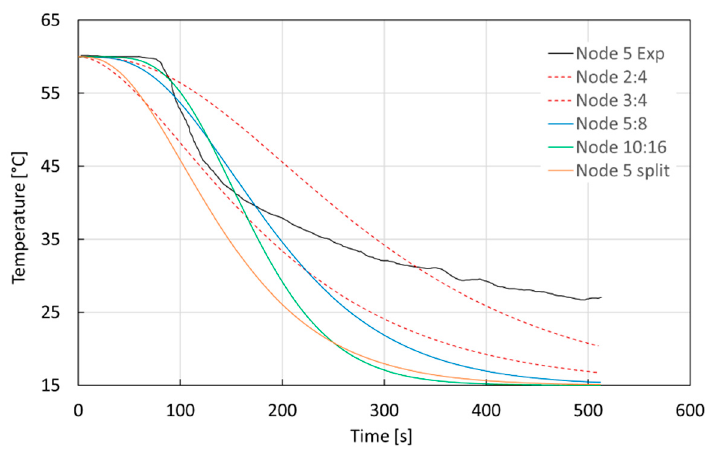
Figure 22. Experimental temperature evolution at node #5 vs. simulation results—15 dm 3 /min volume flow rate—discharge phase.